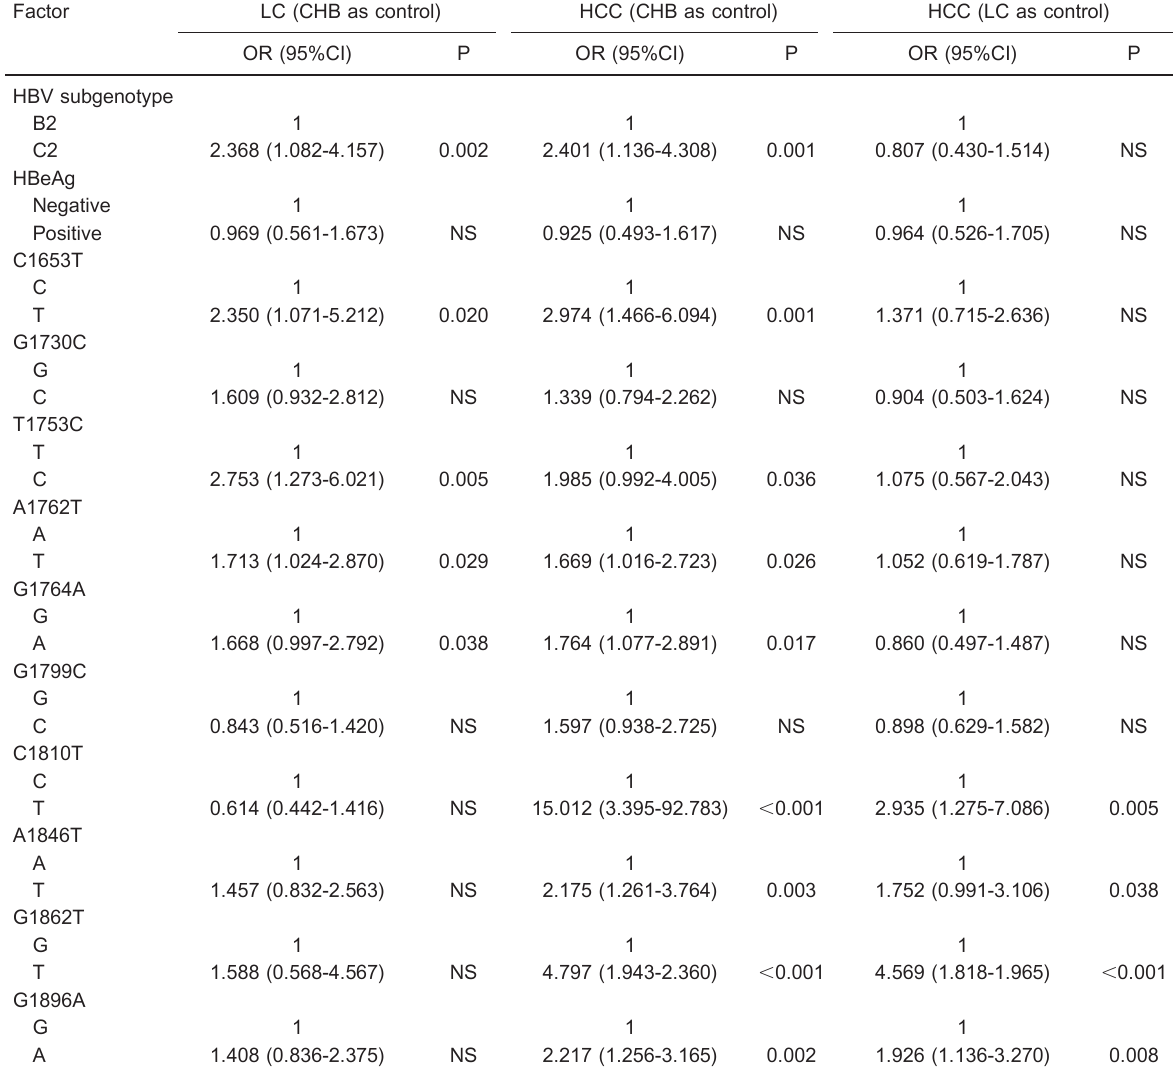
Table 7. Multivariate analysis of independent risk factors for LC and HCC,